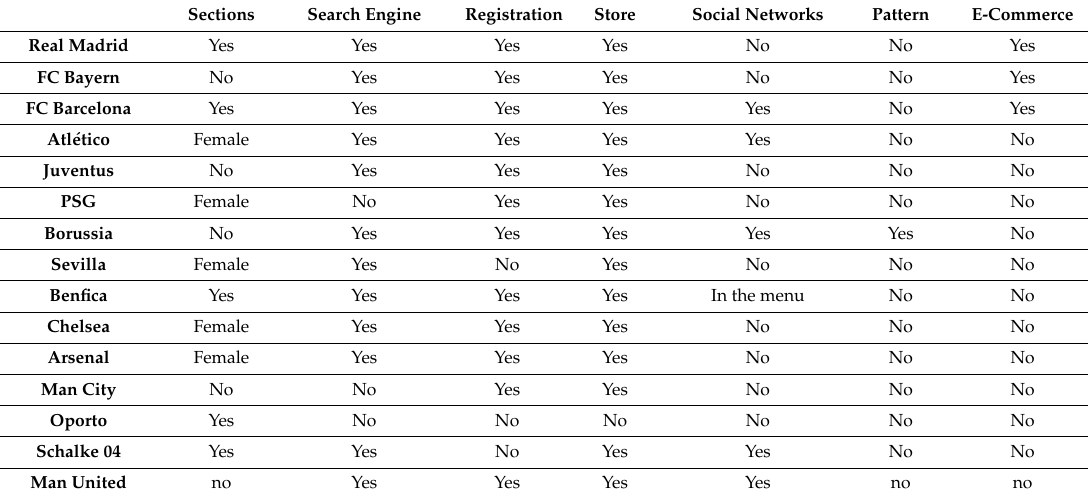
Table 4. Distribution of the header.